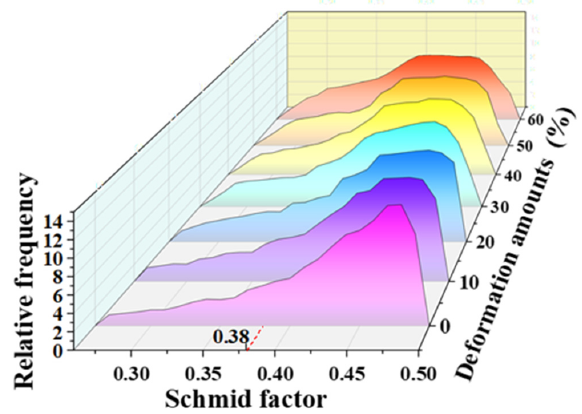
Figure 6. SF value distribution at di ff erent CRF deformation amounts.